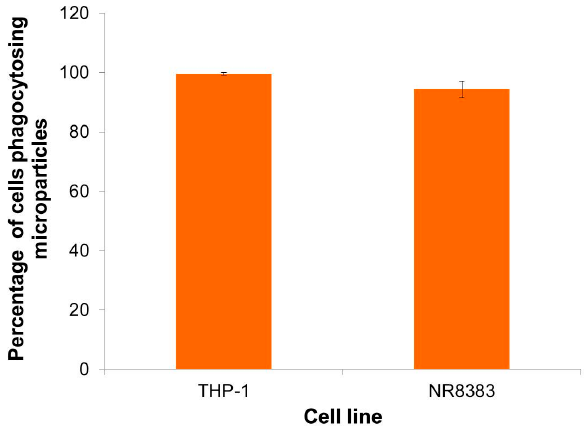
Figure 10. Uptake of fluorescently-labelled locust bean gum (LBG) microparticles by macrophage- Figure 10. Uptakeoffluorescently-labelledlocustbeangum(LBG)microparticlesbymacrophage-differentiated differentiated THP-1 cells and NR8383 cells upon exposure to 50 μ g/cm 2 , for a period of two hours. THP-1 cells and NR8383 cells upon exposure to 50 µ g/cm 2 , for a period of two hours. Results are Results are expressed as mean ± SEM ( n ≥ 3). expressed as mean ˘ SEM ( n ě